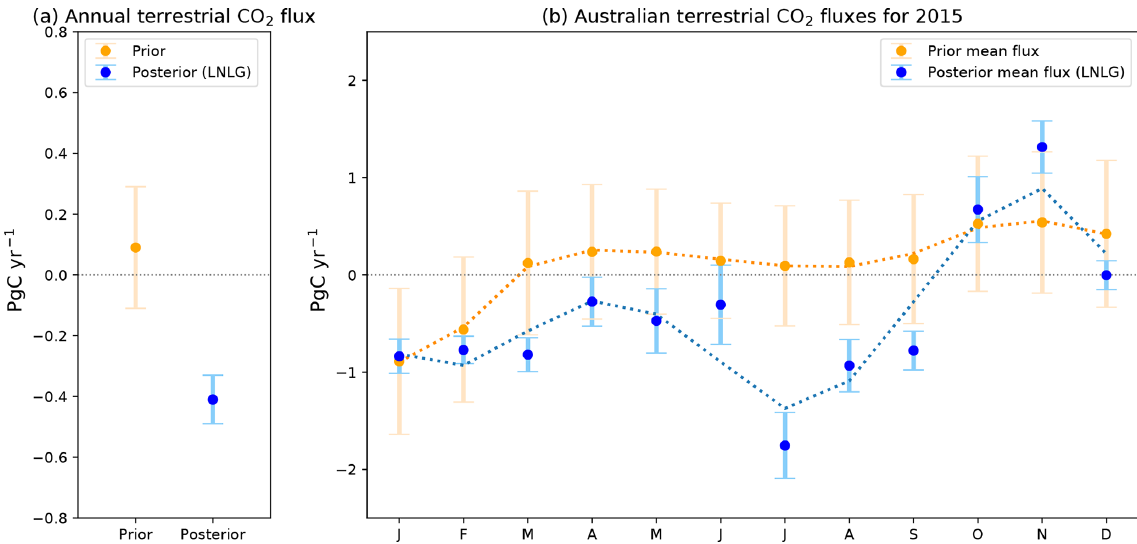
Figure 5. Time series of monthly mean prior (orange dots) and posterior (blue dots) CO 2 fluxes and their uncertainties in PgCyr − 1 over Australia for 2015. The dashed orange and blue line represents a smooth line for the prior and posterior fluxes, respectively.